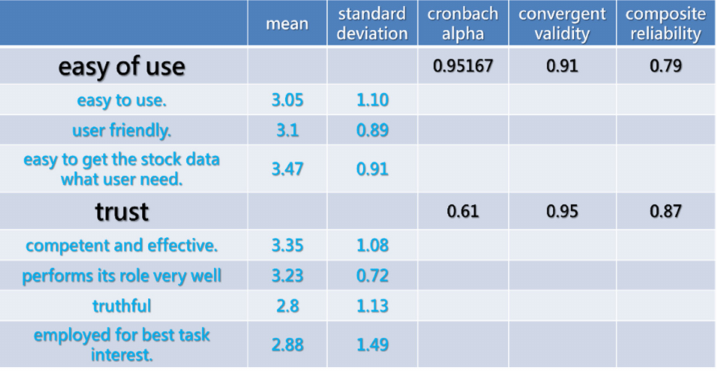
Figure 18. Descriptive and user opinion